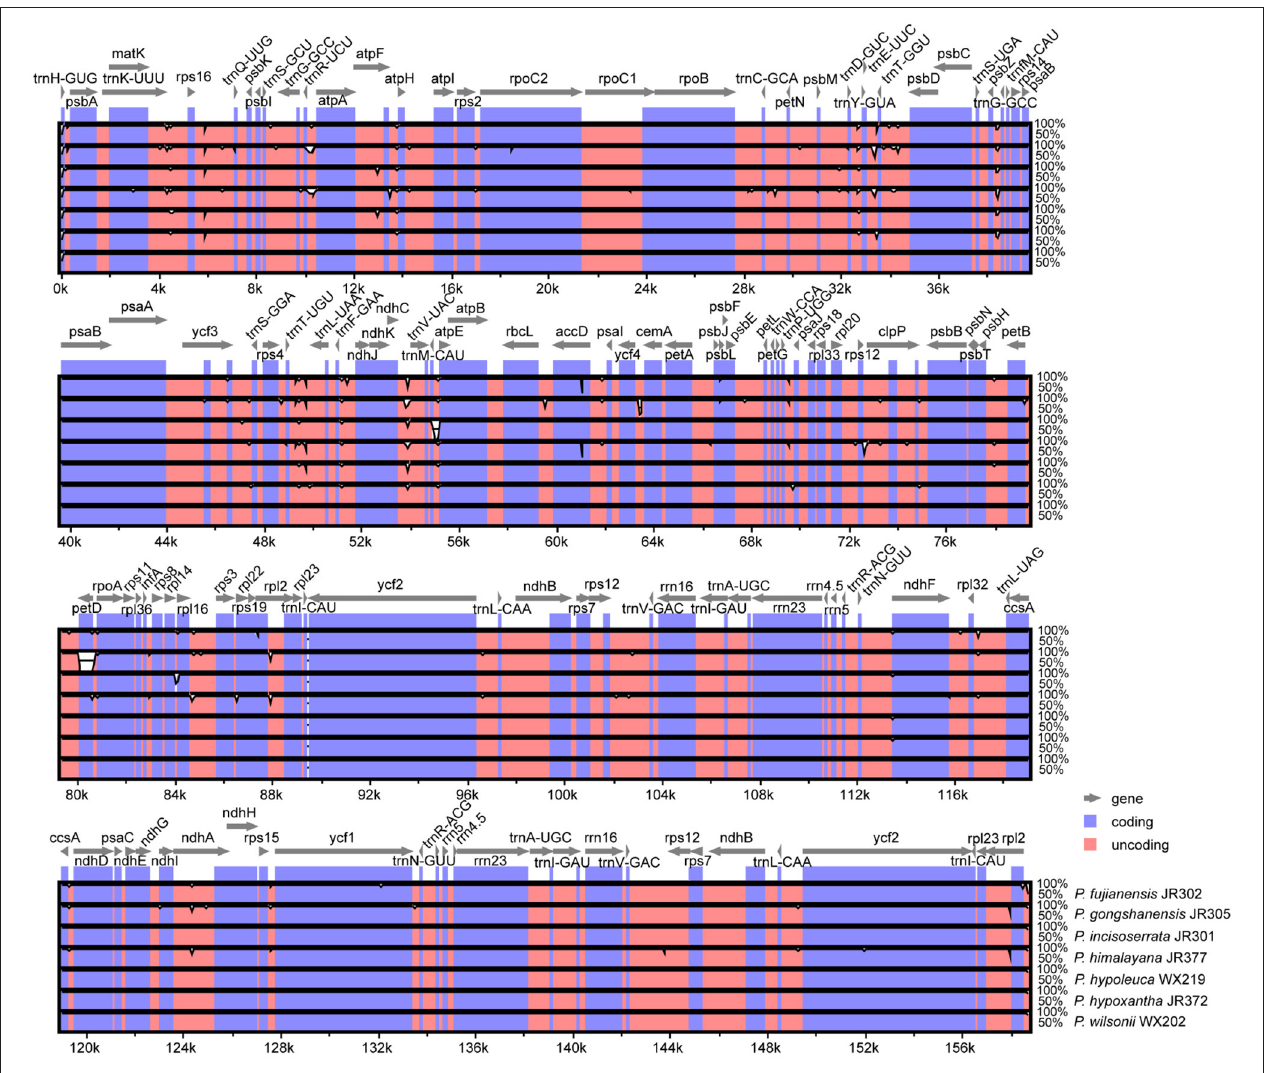
FIGURE 3 | Visualization of alignment of the seven Maddenia chloroplast genome sequences using mVISTA. P . wilsonii WX202 was used as a reference sequence. Blue represents coding regions, and pink represents non-coding